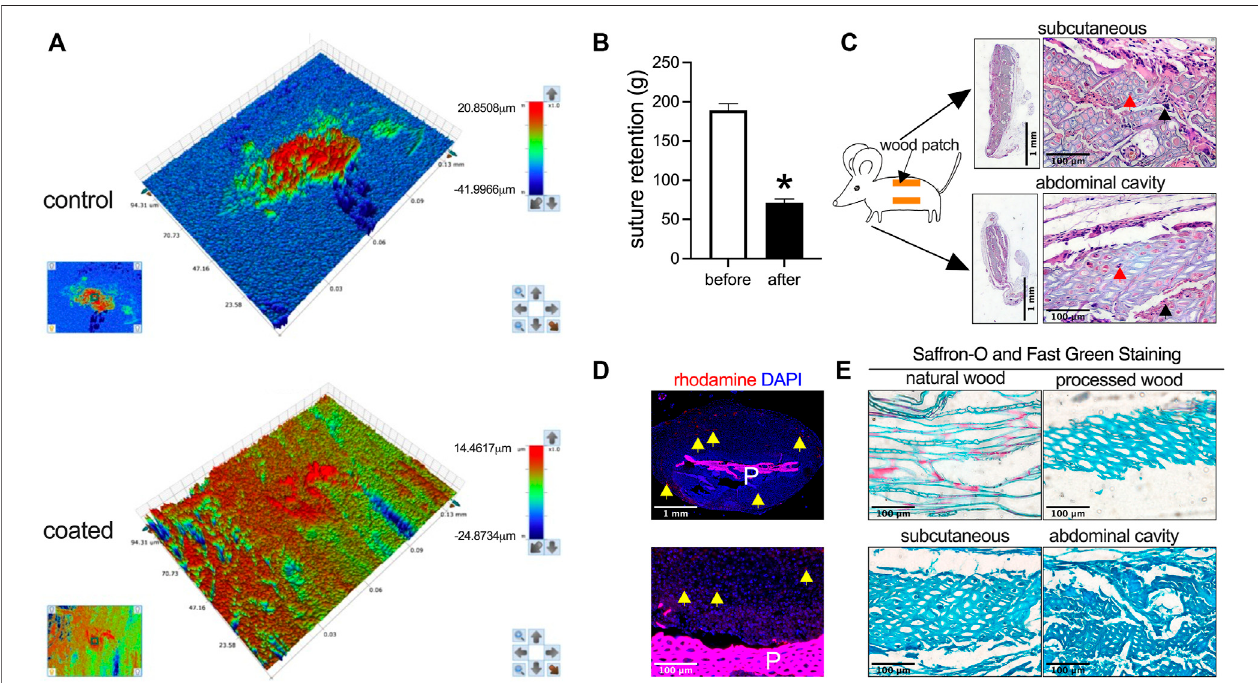
FIGURE2| Biocompatibilityofwoodpatchesintheratsubcutaneoustissueandtheabdominalcavity. (A) Representative3Dopticalmicroscopyimagesofcontrol and HA-coated wood patches ( n = 3). (B) Bar graph showing the suture retention (* p = 0.0003; t -test; n = 3). (C) Low and high-power photographs of hematoxylin and eosin (H&E) staining of the wood patch harvested on day 14 from rat subcutaneous tissue and the abdominal cavity; black arrowhead shows cell in fi ltration along the interspace between the fi bers; red arrowhead shows cell in fi ltration into the fi bers; scale bar, 1 mm or 100 μ m; n = 3. (D) Immuno fl uorescence showing the rhodamine-conjugatedwoodpatchharvestedonday14fromtheratsubcutaneoustissue;upperpanelshowslowpower,andlowerpanelshowshighpower;P,patch; scale bar, 1 mm or 100 μ m; yellow arrow showing the rhodamine fl uorescence; n = 3. (E) Saffron-O and Fast Green Staining of the natural wood and processed wood, harvested from the rat subcutaneous tissue and abdominal cavity; the red staining of the ligni fi ed wood tissue in the natural wood should be noted; scale bar 100 μ m; n =